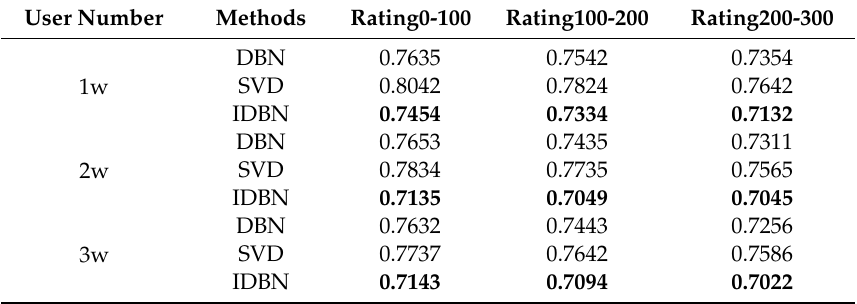
Table 4. Route mean square error (RMSE) of each recommendation algorithm under di ff erent sparseness data.